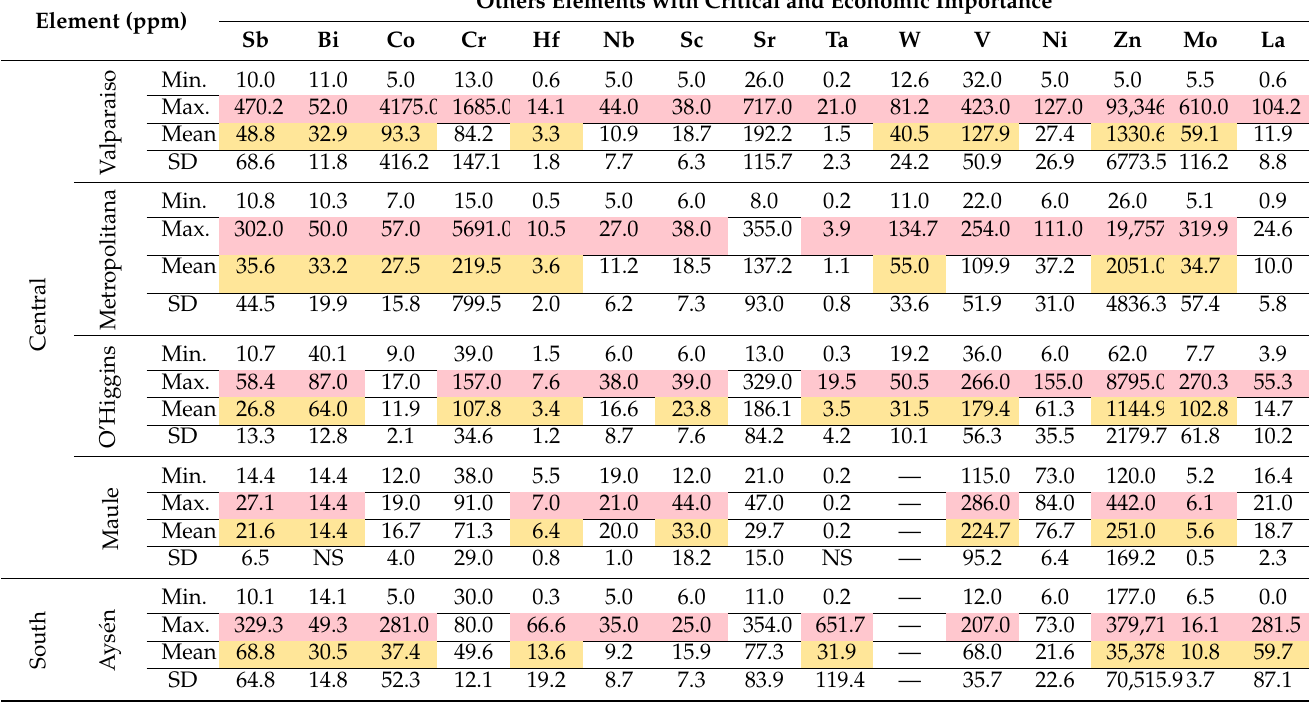
For example, La (average: 60 ppm versus 39 ppm), Ce (average: 101 ppm versus 67 ppm), Pr (average: 13 ppm versus 9 ppm), Nd (average: 52 ppm versus 42 ppm), Tb (average: 1.4 ppm versus 1.2 ppm) and Dy (average: 7.3 ppm versus 5.2 ppm). In terms of